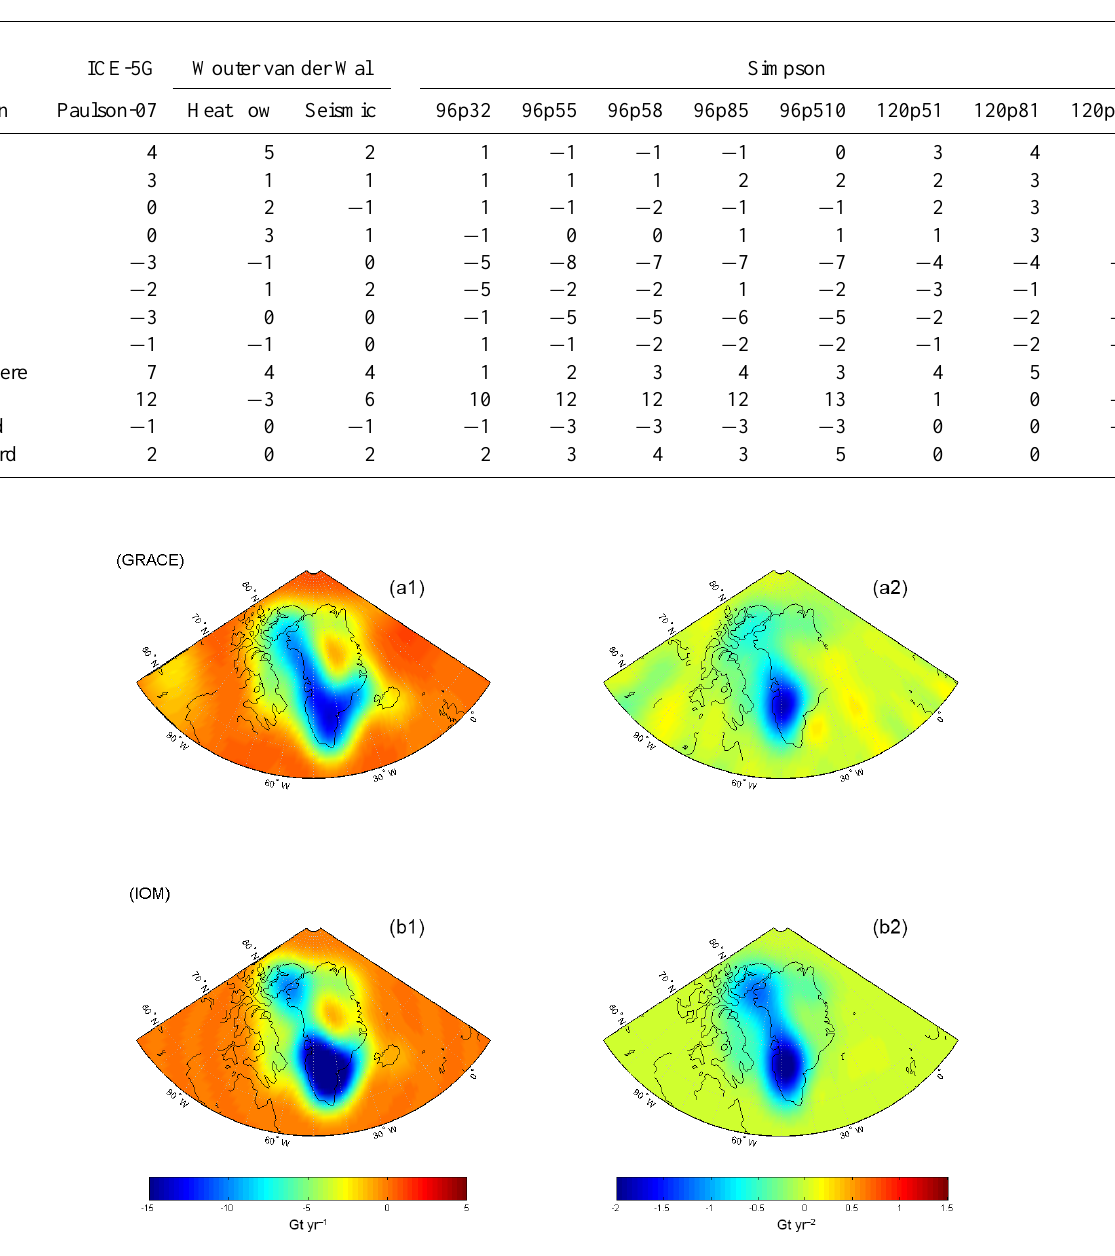
Figure A1. The equivalent water thickness of the linear trend (a1) and acceleration (a2) in CSR release 5 level 2 GRACE data. The linear trend (b1) and the acceleration (b2) of IOM solution in EWH. The time interval is January 2003 to January 2012. The Gaussian filter half-width r 1 / 2 used for all plots is